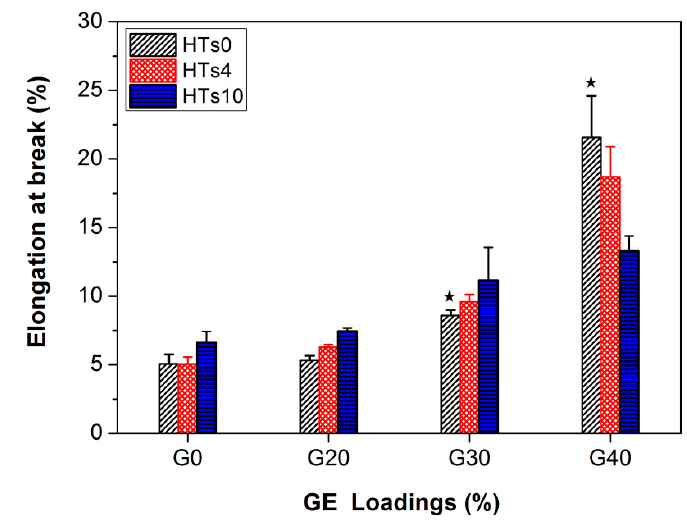
Figure 7. Elongation at break (EB) of FG/GE/HT composites with various HT and GE loadings. * denotes significant difference between FG films containing different percentages of GE ( p < 0.05).